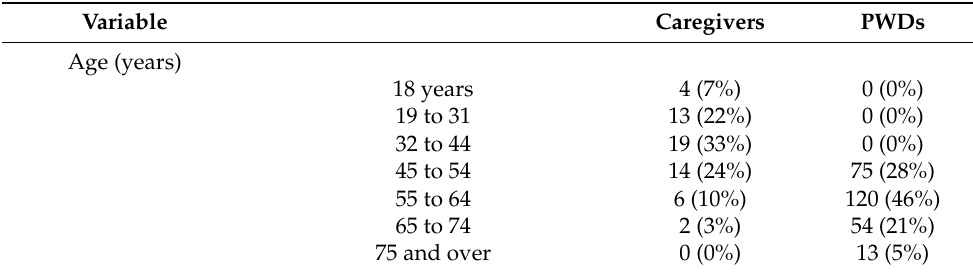
Table 1. Sample demographic characteristics ( n =